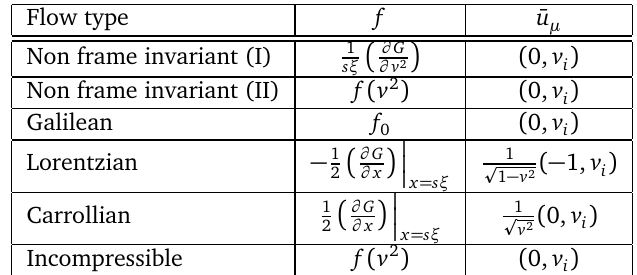
(cid:0) (cid:1) f ¯ u µ from